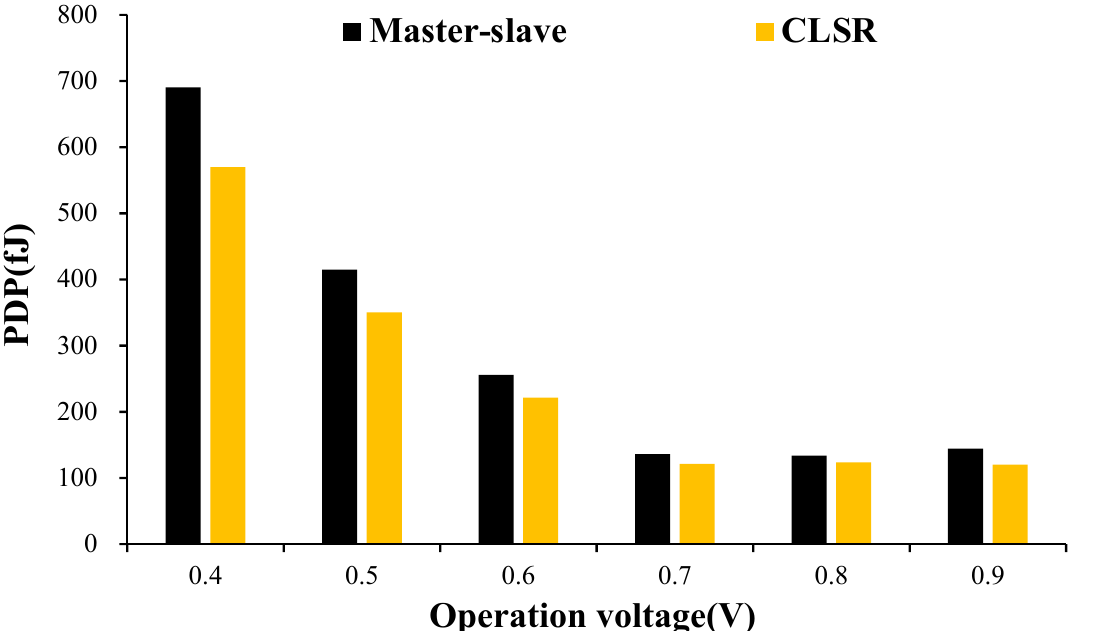
Figure 10. Power delay product performance at different supply voltages. Table 2. Performance comparison of shift registers at TSMC 40 nm. Master–Slave Latch